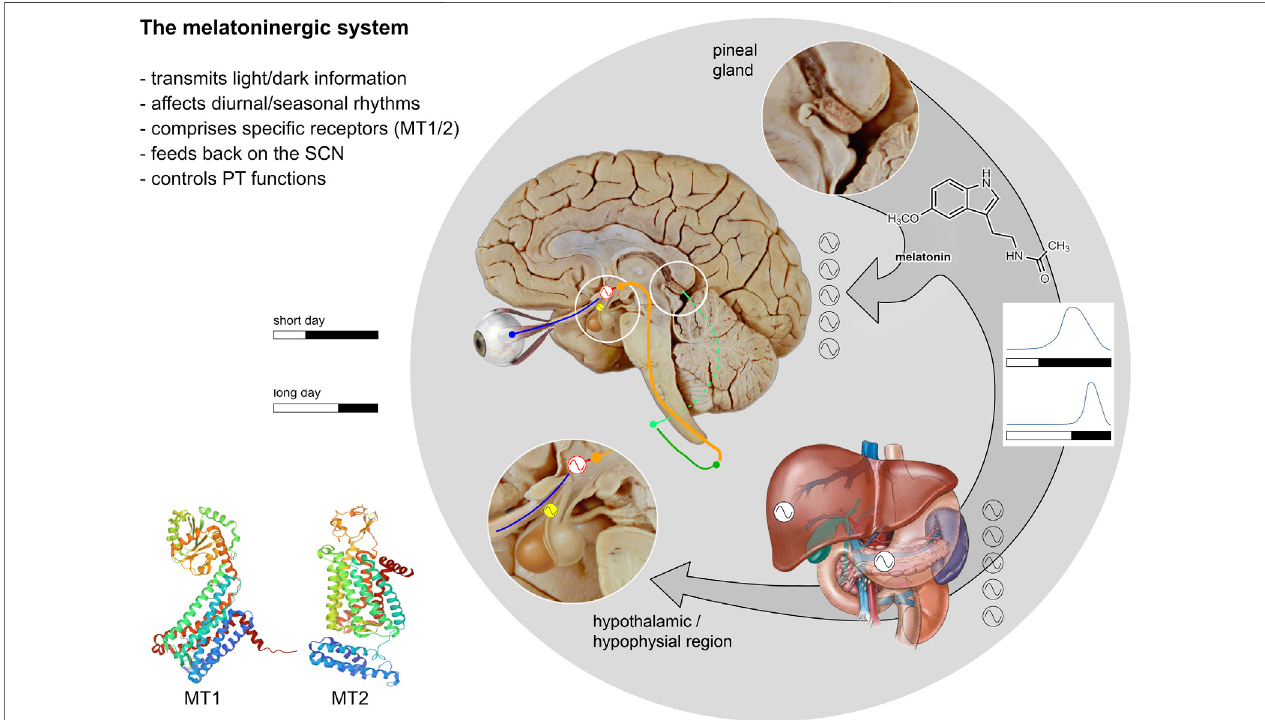
FIGURE 1 | Relationships between the melatoninergic system and the circadian system. The melatoninergic system comprises the neurohormone melatonin and itsmoleculartargetsandiscloselyconnectedtothecircadiansystem.ThecoreofthecircadiansystemislocatedinthehypothalamicSCN(redsinuscurve)producinga self-sustained endogenous rhythm with a period length of approximately 24 h. This circadian rhythm generated in the SCN is entrained to the ambient light/dark cycle- which varies with time of day or season (see diagrams). Light/dark signals are received by melanopsinergic ganglion cells of the retina and transmitted to the SCN via the retino-hypothalamic tract (blue). The SCN sends efferent projections to the adjoining paraventricular nucleus (shown in orange), which is the main source of descending autonomic projections to the spinal cord. The pineal gland, the major source of the neurohormone melatonin, is controlled by the sympathetic innervation comprising theintermediolateralcolumn ofthethoracicspinalcord (dark green) andthesuperiorcervicalganglion(lightgreen).Thepinealglandsynthesizesand secrets melatoninatnightunderthecontroloftheSCN.Thus,melatoninrepresentsanoutputsignalofthecircadiansystem.Thelengthofthemelatoninsignalcorrespondswith the length of the dark phase (see light/dark diagrams). Via the blood stream, melatonin provides a humoral signal synchronizing various peripheral oscillators (black and whitesinuscurves)withtheday/nightrhythm.Themainmoleculartargetsofmelatoninarethetwomelatoninreceptors:MT1andMT2,whicharelocatedthroughoutthe bodyandbrain.Withinthebrain,thehighestMT-receptordensitiesarefoundintheSCN.Thus,melatoninisnotonlyanoutputsignal,butalsoaninputsignaltotheSCN. The pars tuberalis ofthe hypophysis(PT, yellow) isanother regionwith highMT-receptor densities. Theoscillatory processes inthePTcriticallydepend onthe melatonin signal. These oscillations are of importance with respect to the maintenance of seasonal rhythms (after Pfeffer et al., 2018; MT1 structure: Stauch et al., 2019; MT2 structure: Johansson et al., 2019).